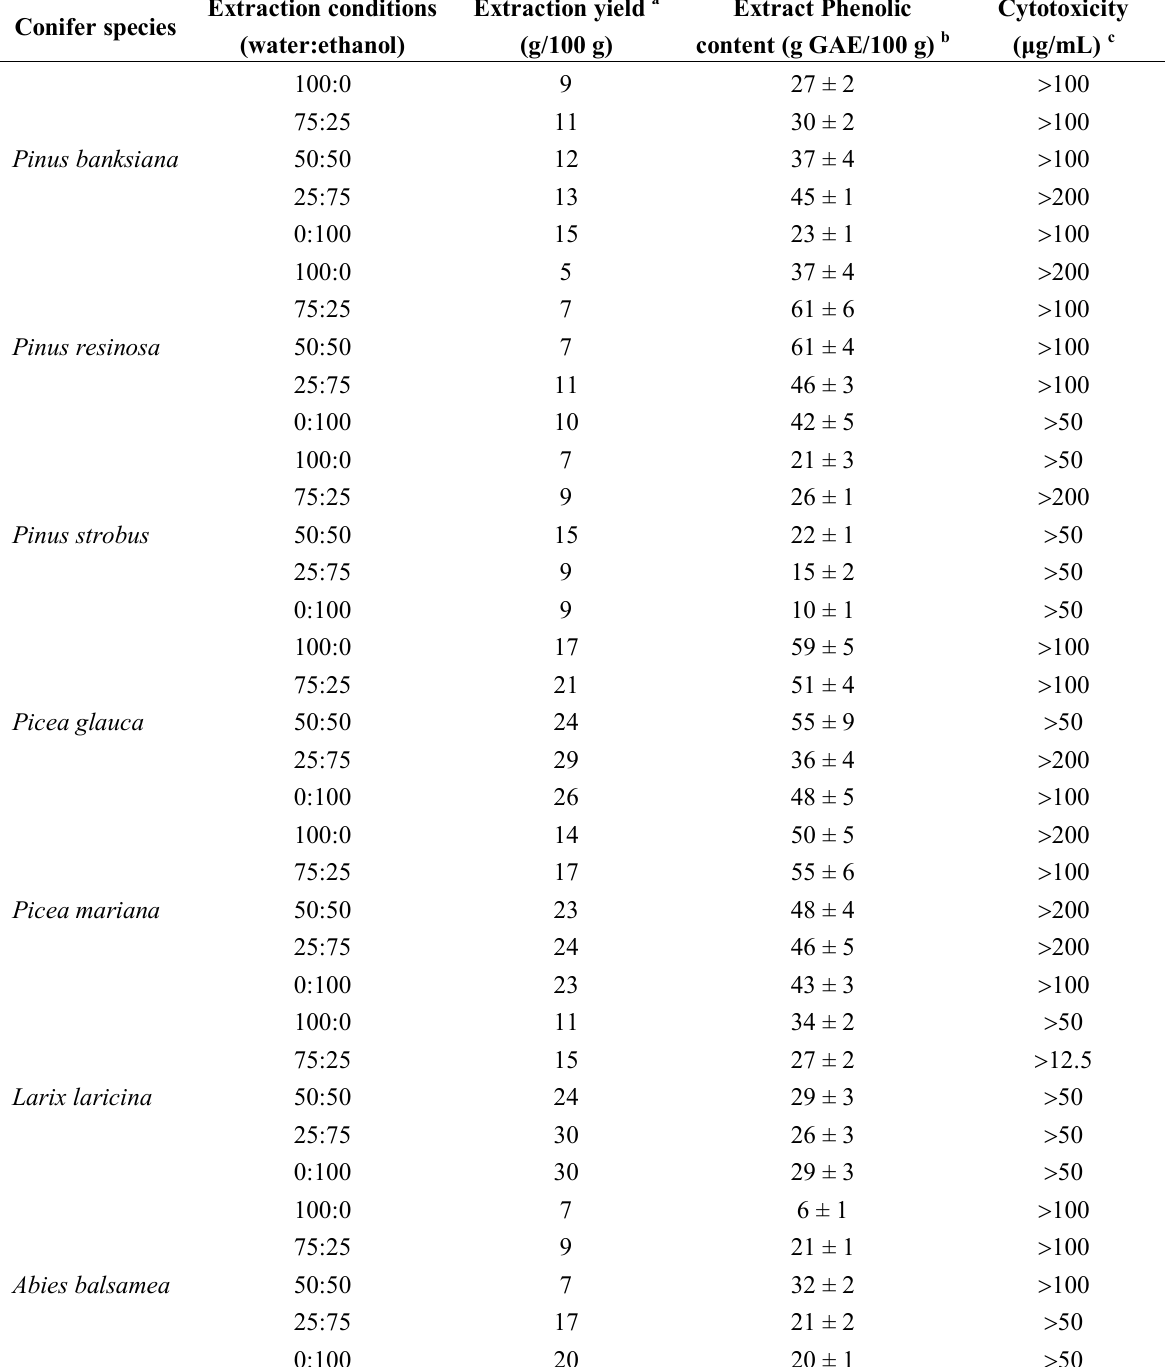
Table 1. Total extraction yield, extract phenolic content and